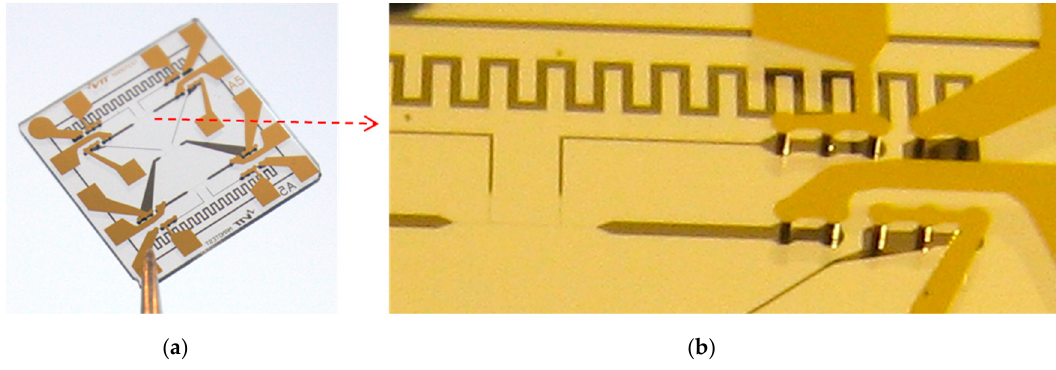
Figure 3. TGV glass chip (picture from the gold contact side) with three 3 ω heater/sensors and two meander shaped heaters ( a ) and larger magnification view showing through glass tungsten vias ( b